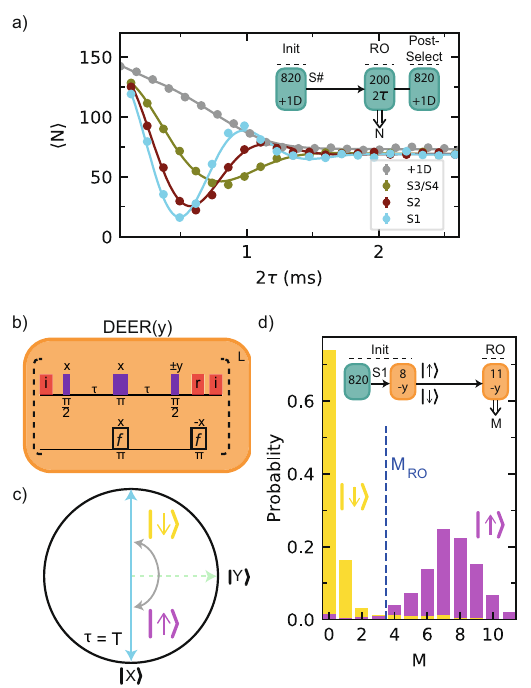
Fig. 3 Electron spin initialization and readout. a Measuring the NV-P1 coupling strength. We initialize S1, S2, or S3/S4 in þ 1 ; D j i and vary the interaction time 2 τ of a DEER sequence. 〈 N 〉 is the mean of the number of NV m s = 0 outcomes for K = 200 repetitions. To improve the signal, the results are post-selected on again obtaining þ 1 ; D j i . Error bars are one